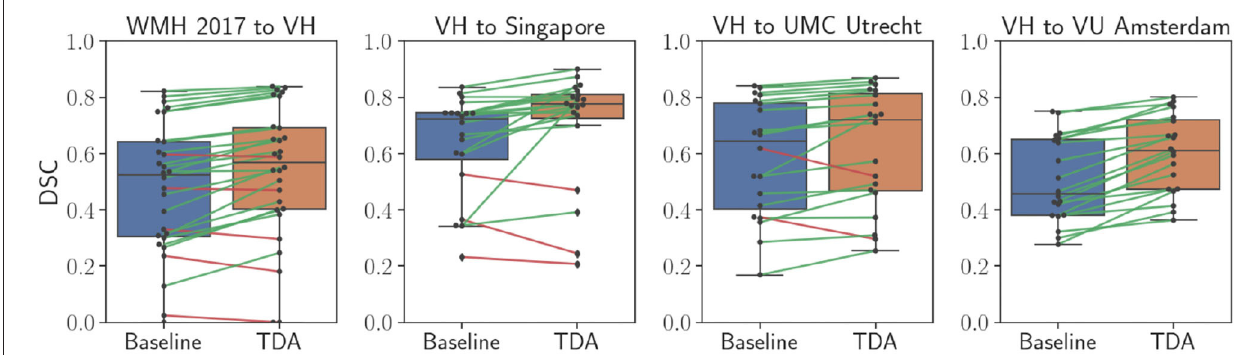
FIGURE 6 | Comparison of WMH lesion segmentation between direct testing (Baseline) and after domain adaptation (TDA). Black dots refer to each subject volume in the target dataset. The connecting lines show correspondence for improved (green) and decreased (red) DSC values.